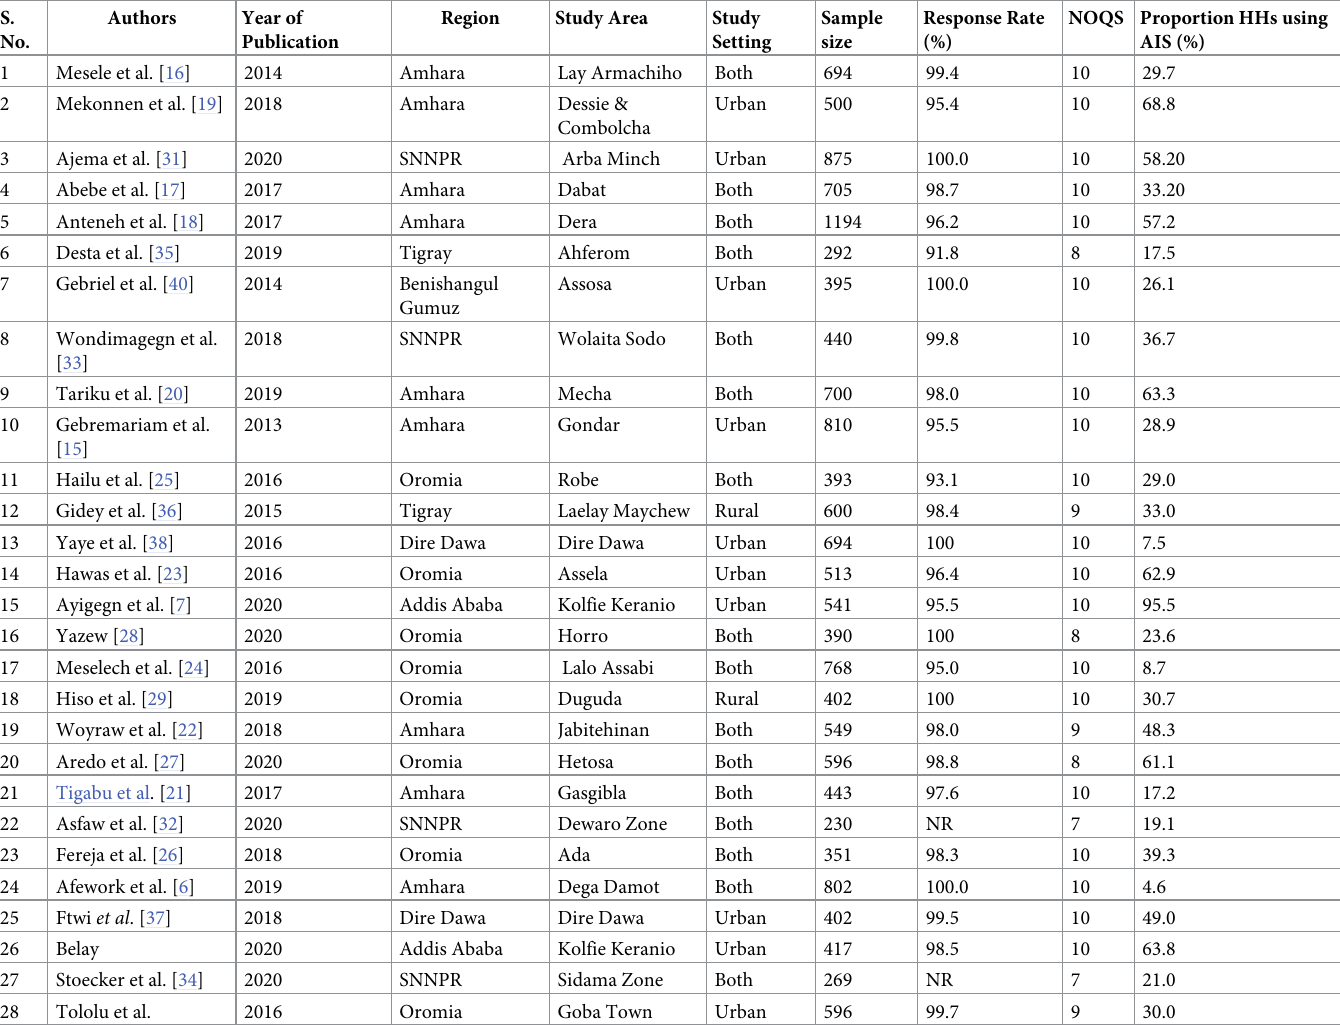
Table 1. Summary of the included studies which were done on the proportion of adequately iodized salt at HH level in Ethiopia, 2013–2020 (n =